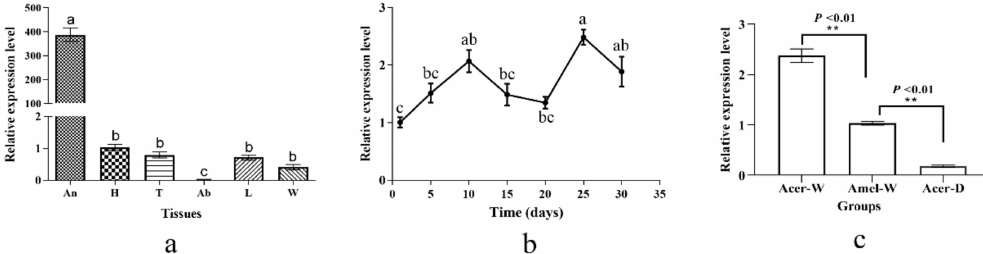
Figure 2. Expression profiles of AcerOBP6. ( a ) Relative expression levels of AcerOBP6 in different tissues (An: antennae; H: head without antennae; T: thorax; Ab: abdomen; L: legs; W: wings) ( b ) in different development stages and ( c ) in different sexes and species. Different lowercase letters above bars indicate significant differences in expression between groups ( p < 0.05). The error bars represent the mean ± standard error. Double asterisks indicate significant differences between the two means ( p < 0.01). Acer-W: antennae of worker bees from A. cerana cerana ; Amel-W: antennae of worker bees from A. mellifera ligustica ; Acer-D: Antennae of drones from A. cerana cerana